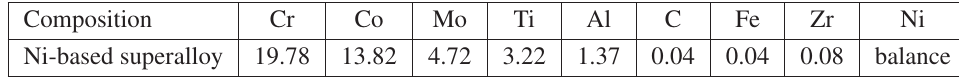
Table 1. Chemical composition of GH 864 Ni-based superalloy (in wt%). for new bond coat materials and/or methods of improving the properties of metallic bond coat system to increase the life time of